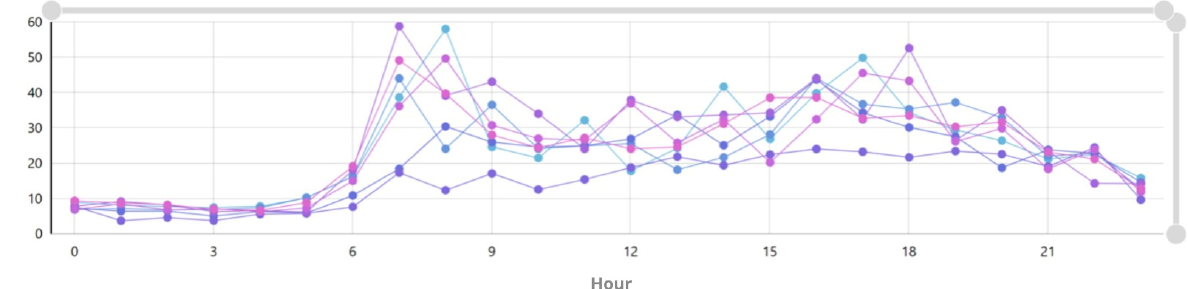
Figure 5. Comparison of several years (one per line) with the maximum temperatures reached for each of the weeks of the year in the same region. It is worth highlighting that the represented values consist of the mean of multiple sensor measurements (coming from various environments like private houses, buildings, streets, etc.) and is disposed in the Fahrenheit scale.